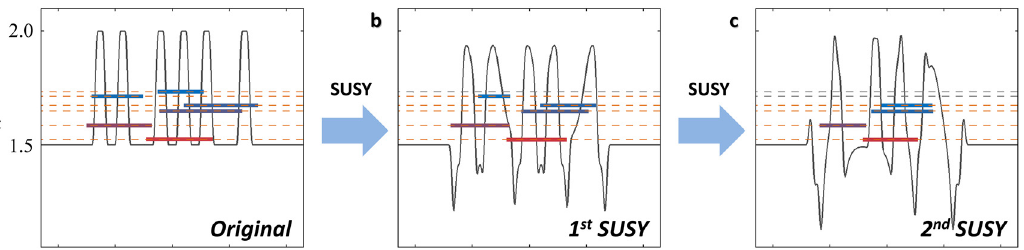
Figure 2: SUSY transformation for quasi-isospectral materials. (a – c) An example of multiple SUSY transformations. (a) Original potential. (b) The 1st and (c) 2nd SUSY-transformed potentials. The n -axis represents both the refractive index pro fi le and effective index of optical modes. The orange (or black) dotted lines denote the preserved (or annihilated)eigenstates.Notethatbecauseofthedifferentsignsinopticalandquantumpotentialsof − n ∼ V ,thegroundstatehasthelargest value of n . Panels (a – c) are adapted from [37], CC BY